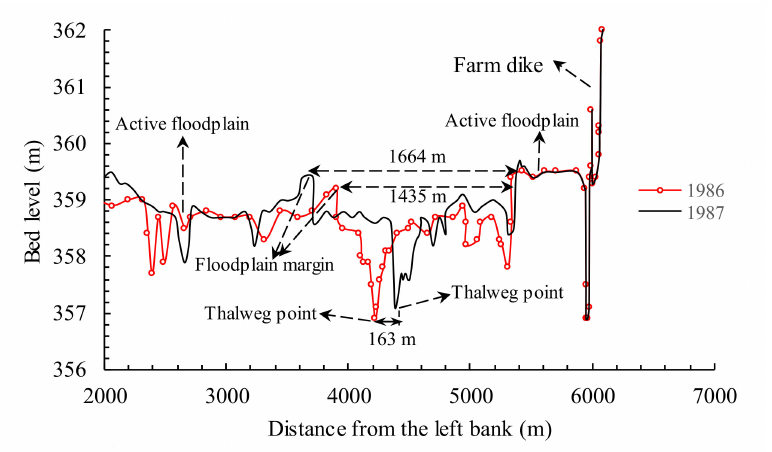
Figure 4. Determination of the bankfull width and thalweg migration distance at the section of